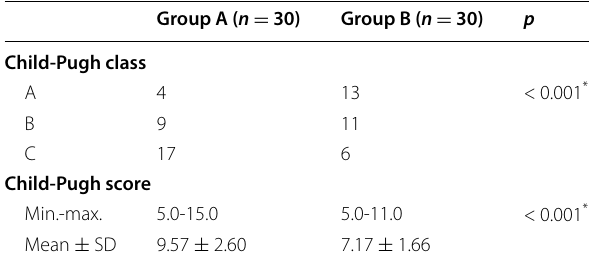
Group A, 30 cases of cirrhosis with esophageal varices Group B, 30 cases of cirrhosis without esophageal varices t Student t test, IQR interquartile range, p p value for comparing between the studied groups *Statistically significant at p ≤